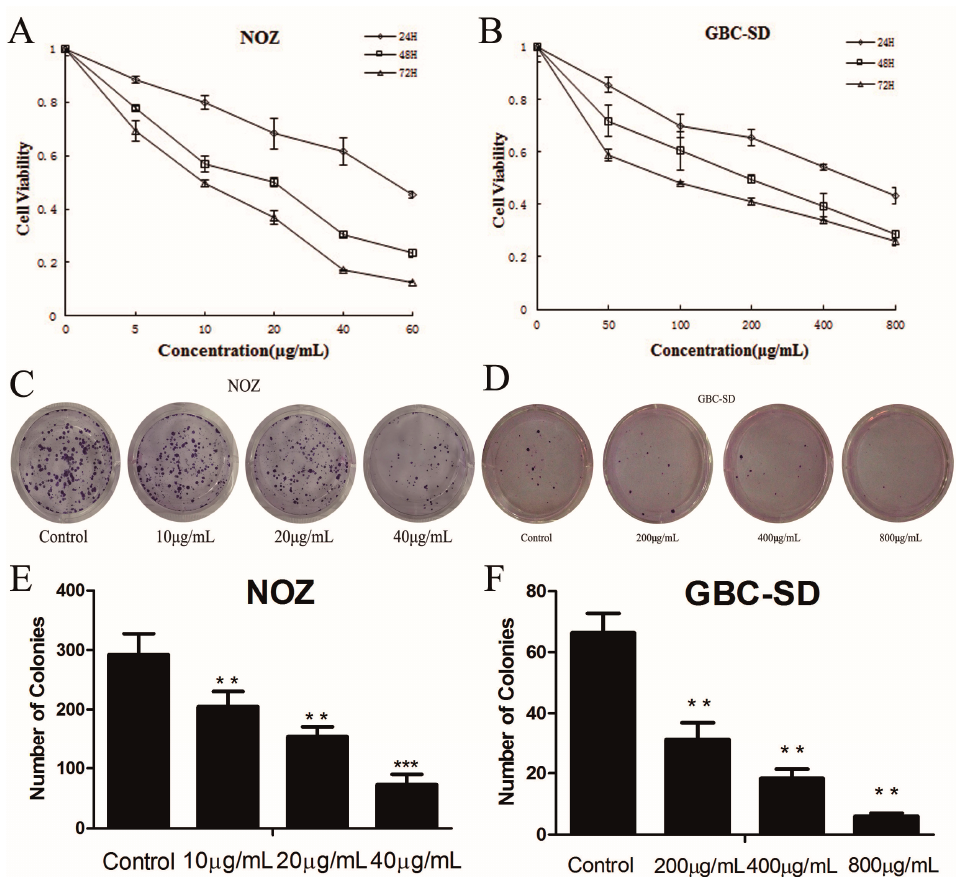
Figure 2. Cordycepin inhibits the proliferation and colony formation of gallbladder cancer